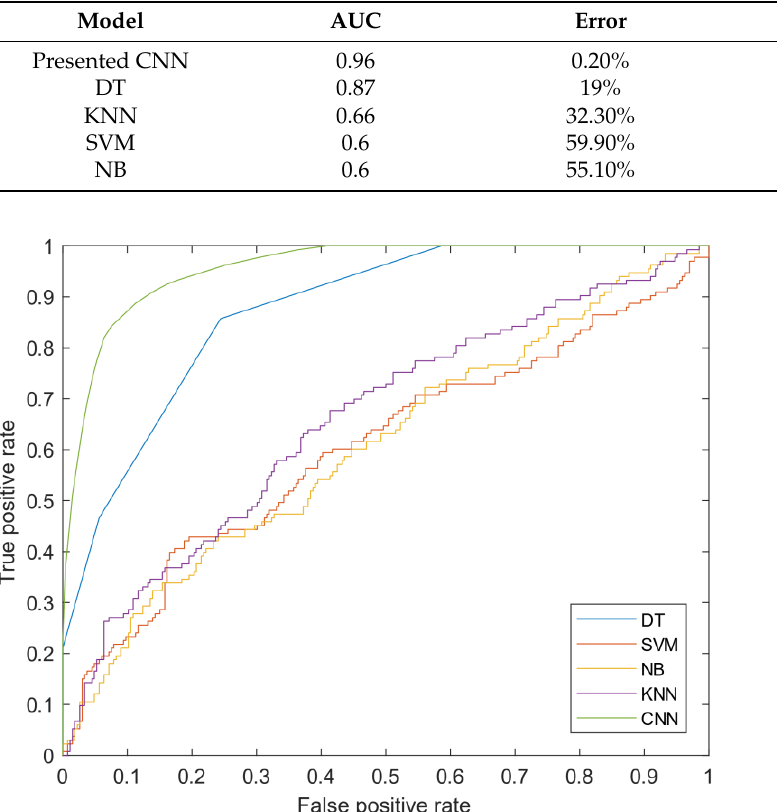
Figure 7. ROC curve for the various classifications presented in the research.